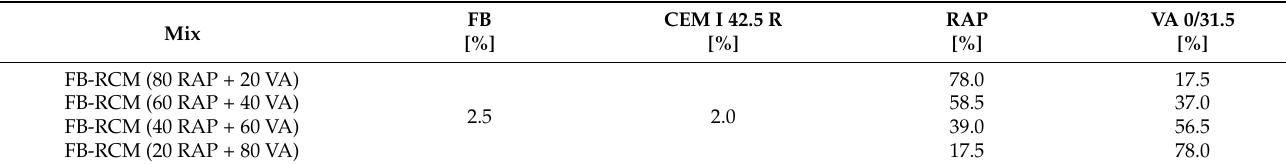
Table 8. Composition of recycled mix with reclaimed asphalt pavement (RC).